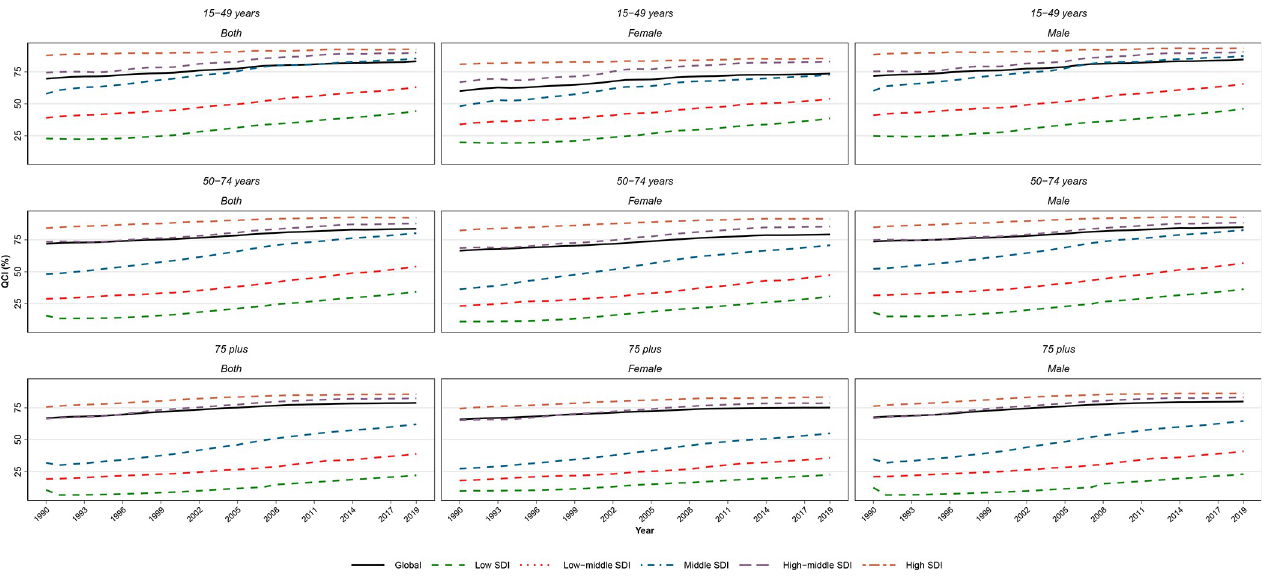
Fig 3. QCI (%) for age-groups of 15–49, 50–74, and 75+ at Global and Socio-demographic index (SDI) quintiles for both genders 1990–2019.